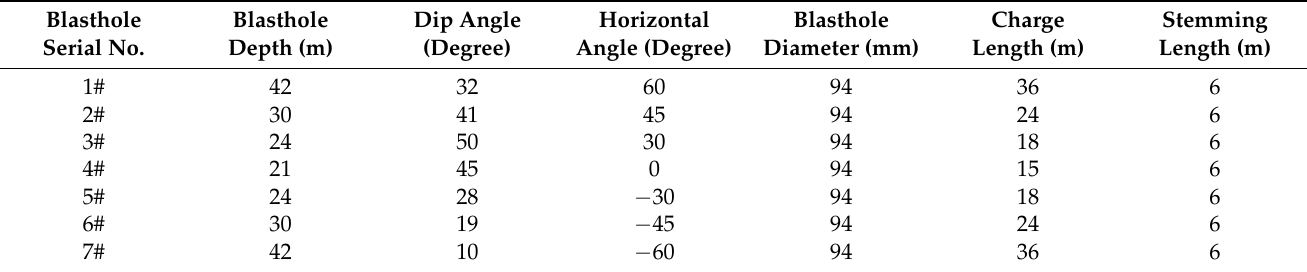
Figure 8. Schematic diagram of charging and sealing structure.